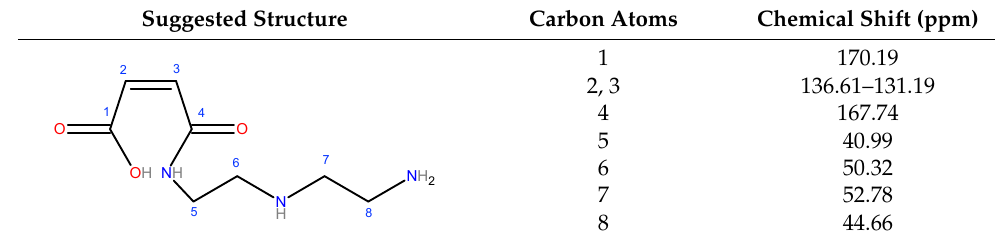
Table 2. 13 C-NMR chemical shifts of native starch.